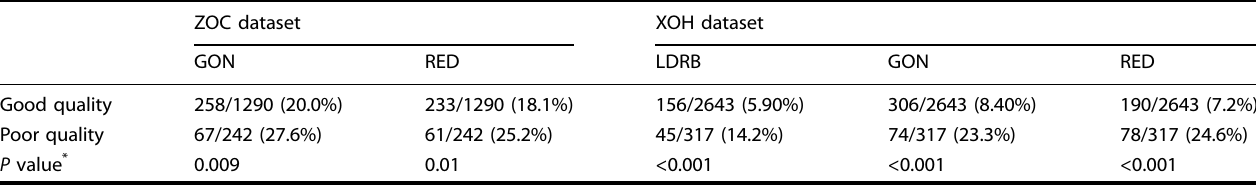
Table 3. Proportions of glaucomatous optic neuropathy, retinal exudation/drusen, and lattice degeneration/retinal breaks in the good-quality and poor-quality images.